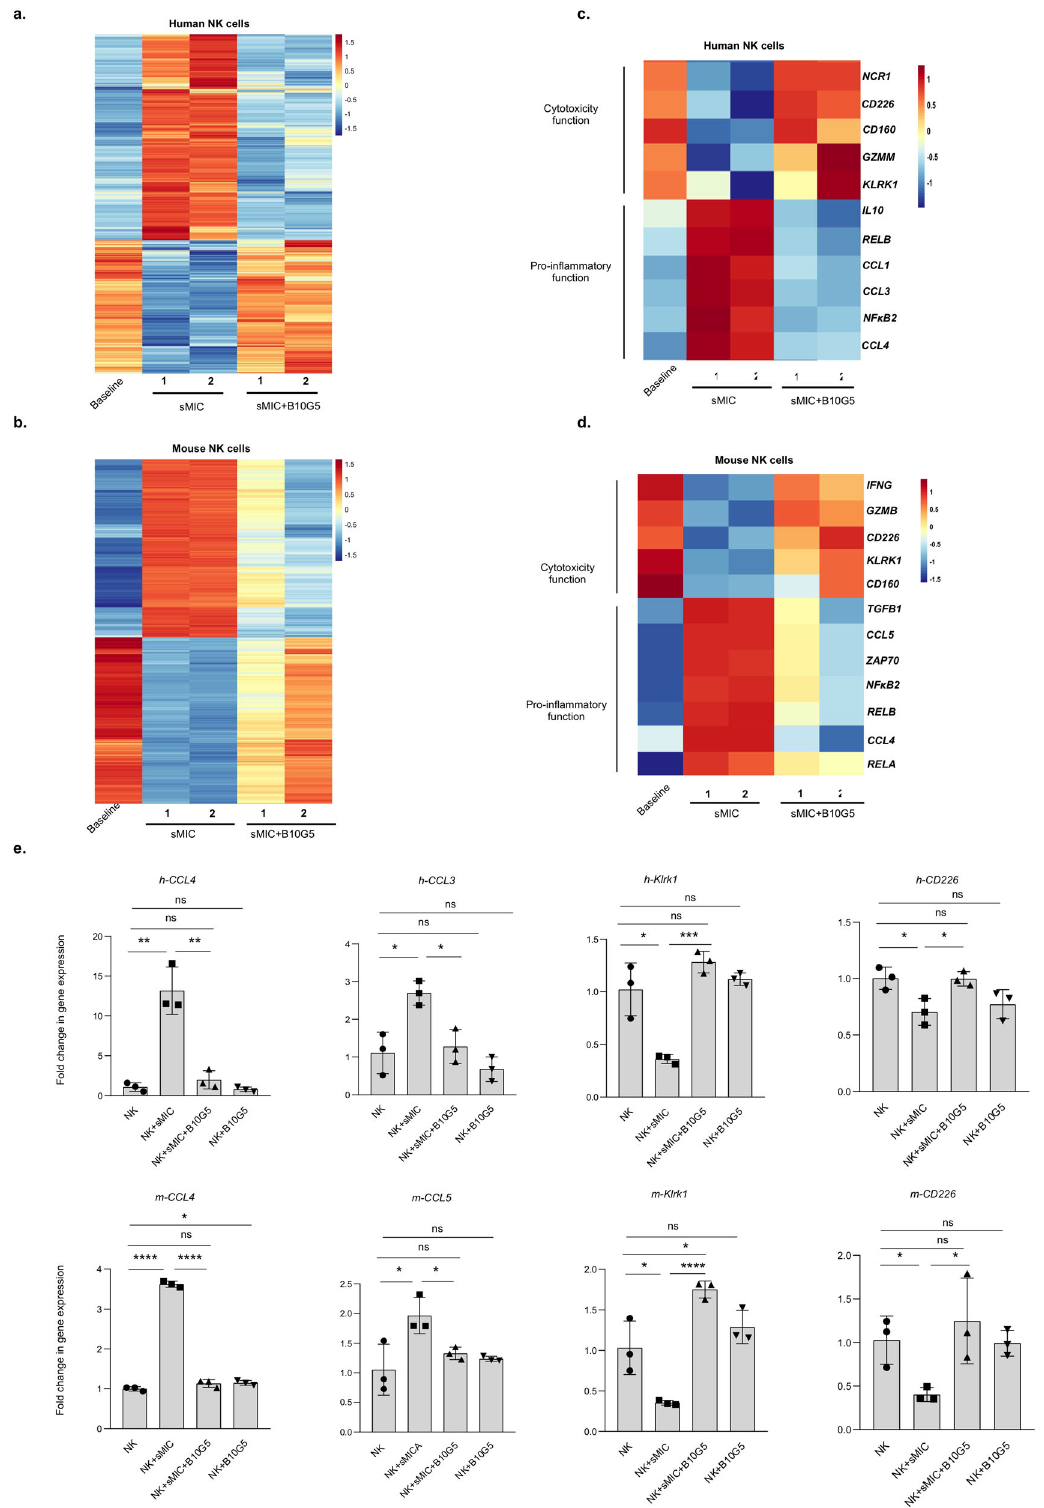
clustering algorithm, a total of 28 distinct clusters were identi fi ed in CD45 + TILs and visualized as a UMAP (Uniform Manifold Approximation and Projection) (Fig. 2c and Supplementary Fig. 3b). Gene set enrichment (GSEA) and gene ontology (GO) pathway analyses of NK cell clusters revealed distinct functional differentiation of NK cells in tumors with sMIC hi and tumors with sMIC lo (Fig. 2d). Using the HIPPO method 31 with